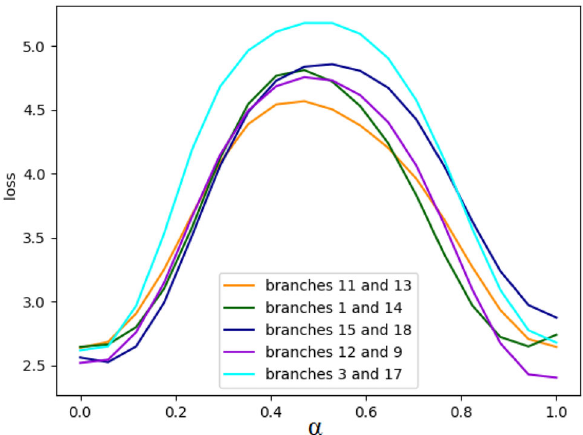
Fig. 5 Loss values on a synthetically created model obtained as a weighted average between a random pair of branches, using different interpolation factors. Example computed on CIFAR-100